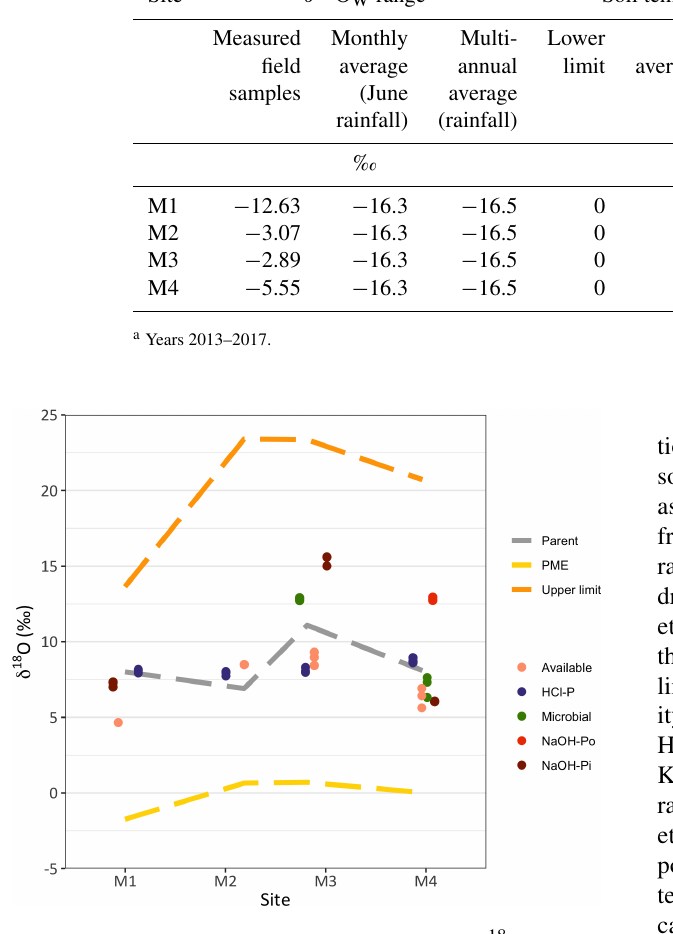
Figure 2. Isotopic values of oxygen in phosphate ( δ 18 O P ) in dif- ferent soil P pools along the Chamser Kangri glacier forefield chronosequence ( < 1, 25, 50 and > 100 years, for M1, M2, M3 and M4, respectively). The expected δ 18 O value of phosphate derived from Po hydrolysis due to phosphomonoesterases (PME, δ 18 O PME ; Eq. 2) is shown by the yellow discontinuous line, while the grey discontinuous line stays for the isotopic value of the parent material and the orange discontinuous line for the upper limit of the short- term isotopic equilibrium. Symbols represent analytical replicates of the same